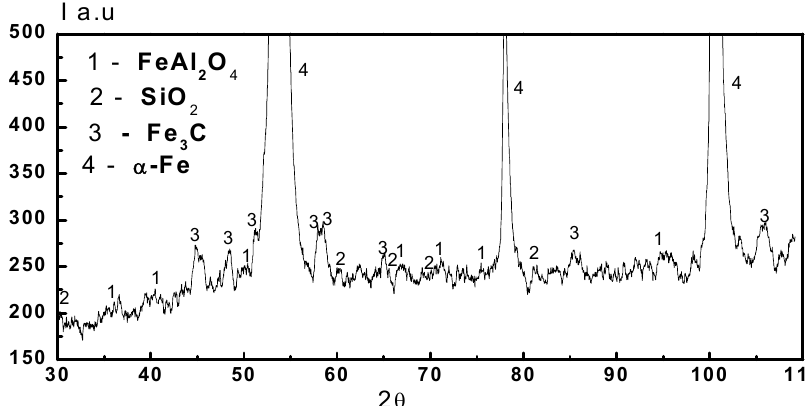
Figure 7. XRD pattern of the layer formed on the friction surface of the 45 steel after the friction testing in pair with the PEO layer synthesized on the AMg-6 alloy in mineral oil of the I-20 type with the addition of 1.0 vol. % aqueous solution of glycerin. The specific load in the friction zone was 4.0 MPa. The designations of revealed phases: 1 —FeAl 2 O 4 ; 2 —SiO 2 ; 3 —Fe 3 C; 4 — α-Fe.